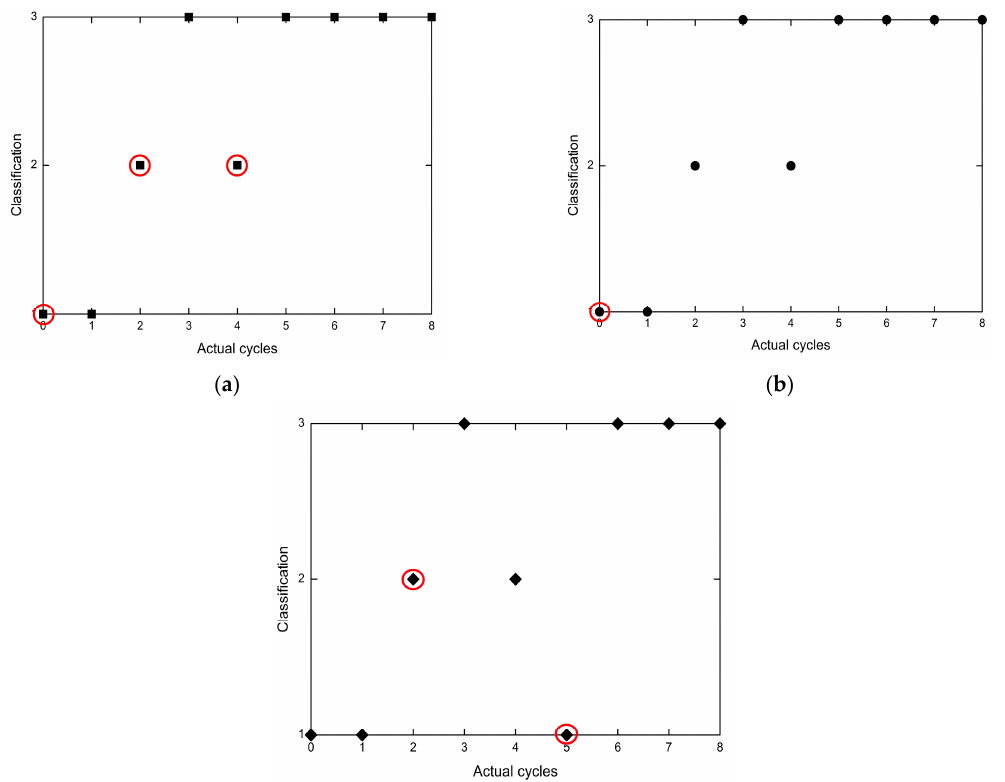
Figure 12. The classification results: (a) Plate 1#; ( b ) Plate 2#; ( c ) Plate 3#.